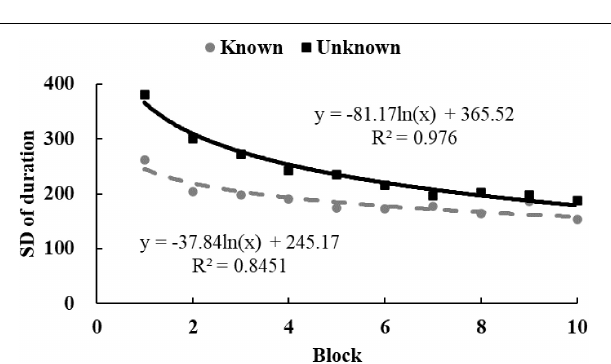
FIGURE 5 | The SD of drawing time in Study 2. The solid and dotted lines represent the regression curves for the unknown and known conditions, respectively.